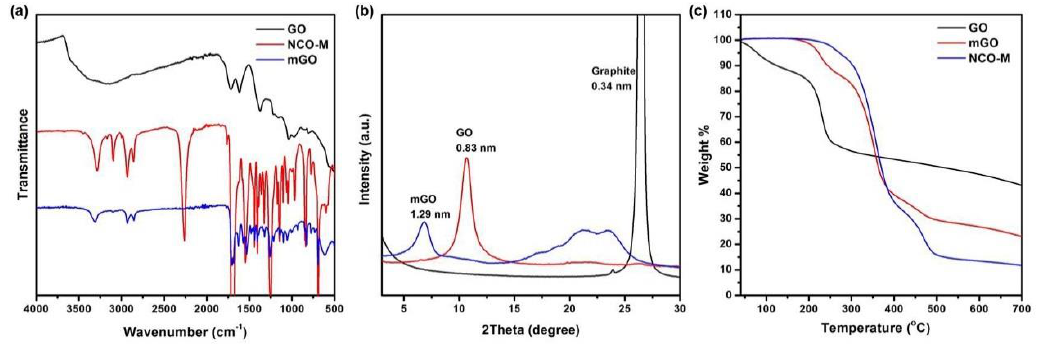
Figure 2. ( a ) FT-IR spectra of GO, NCO-M and mGO, ( b ) XRD patterns of graphite, GO and mGO and ( c ) TGA curves of GO, NCO-M and mGO.